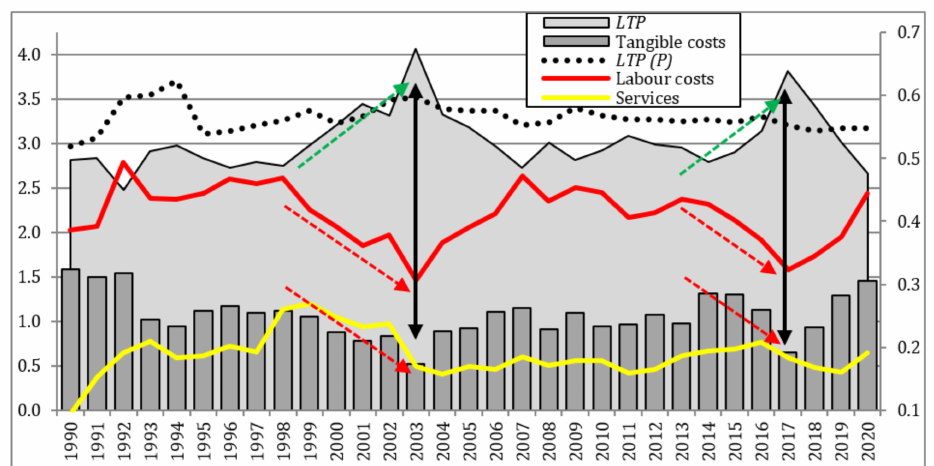
Figure 3. Productivity of labour and tangible costs ( LTP ), and components of cost intensity in coal mining companies in 1990–2020. Note: LTP —standardised values, left axis. LTP(P) —productivity of labour and tangible costs for production enterprises. Source: author’s research based on